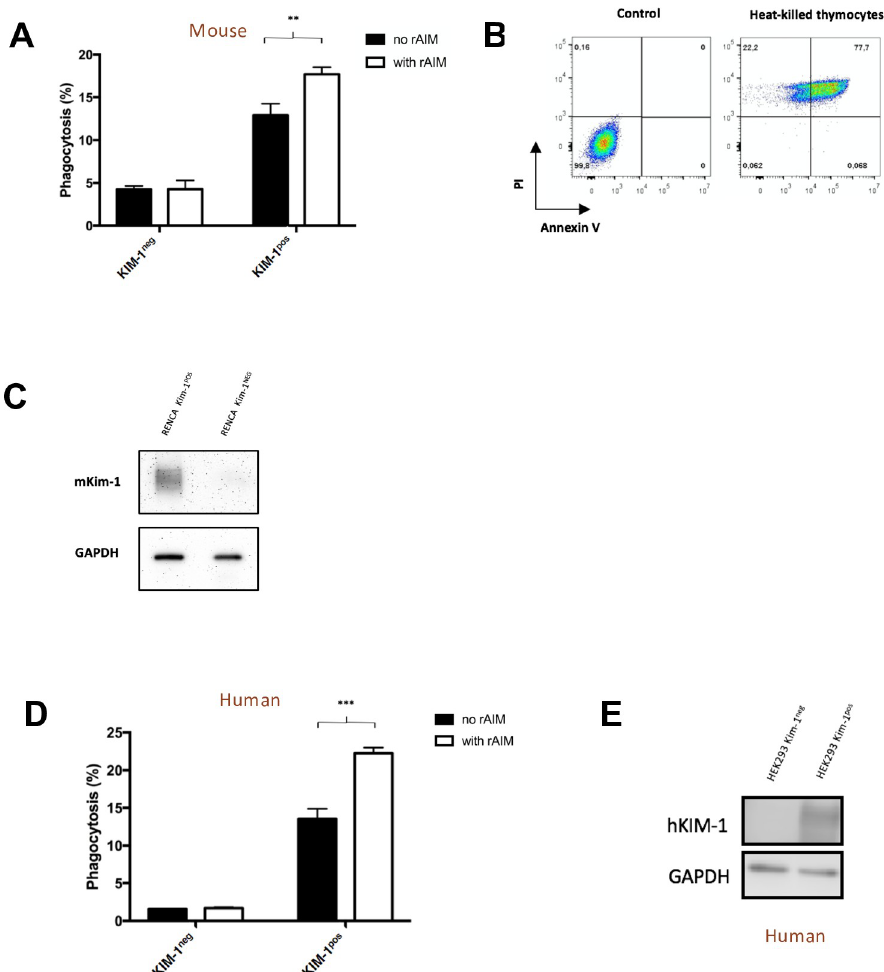
Fig 3. Recombinant AIM enhances the phagocytic uptake of necrotic cells by both KIM-1 expressing mouse and human kidney cells. Renca cells (mouse) or HEK293 (human) expressing KIM-1 or without KIM-1 were fed necrotic thymocytes with or without rAIM (A-C). (A) Renca cells (mouse) after a 90-minute incubation, % phagocytosis was quantified using flow cytometry. (B) Immunotyping of necrotic cell populations. (C) Western Blots were performed confirming the expression of KIM-1 on Renca cells. (D) HEK 293 cells (human) after a 90-minute incubation, % phagocytosis was quantified using flow cytometry. (E) Western Blots were performed confirming the expression of KIM-1 on HEK293 cells. Histograms are representative results of at least 3 independent experiments. All flow cytometry experiments were analyzed using FlowJo X software. �� p < 0.01, ��� p < 0.001.